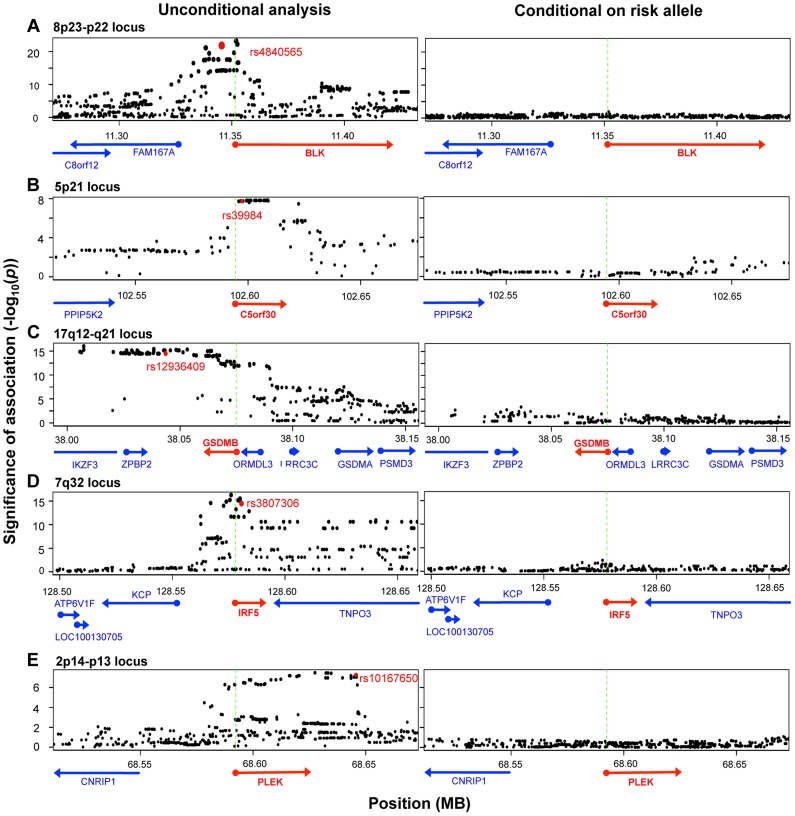
Five disease risk alleles explained the eQTL associations with five genes.The left-sided panels show unconditional SNP-expression association results. Green dashed lines mark the TSS of the eQTL gene. The red dots indicate the risk alleles associated with the expression of respective genes shown as red arrows. The right-sided panels show adjusted association results after conditioning for the respective risk alleles. In each of the five loci, conditioning on the disease SNP obviated signals in the entire region, such that no association more significant than p = 0.05 remains.